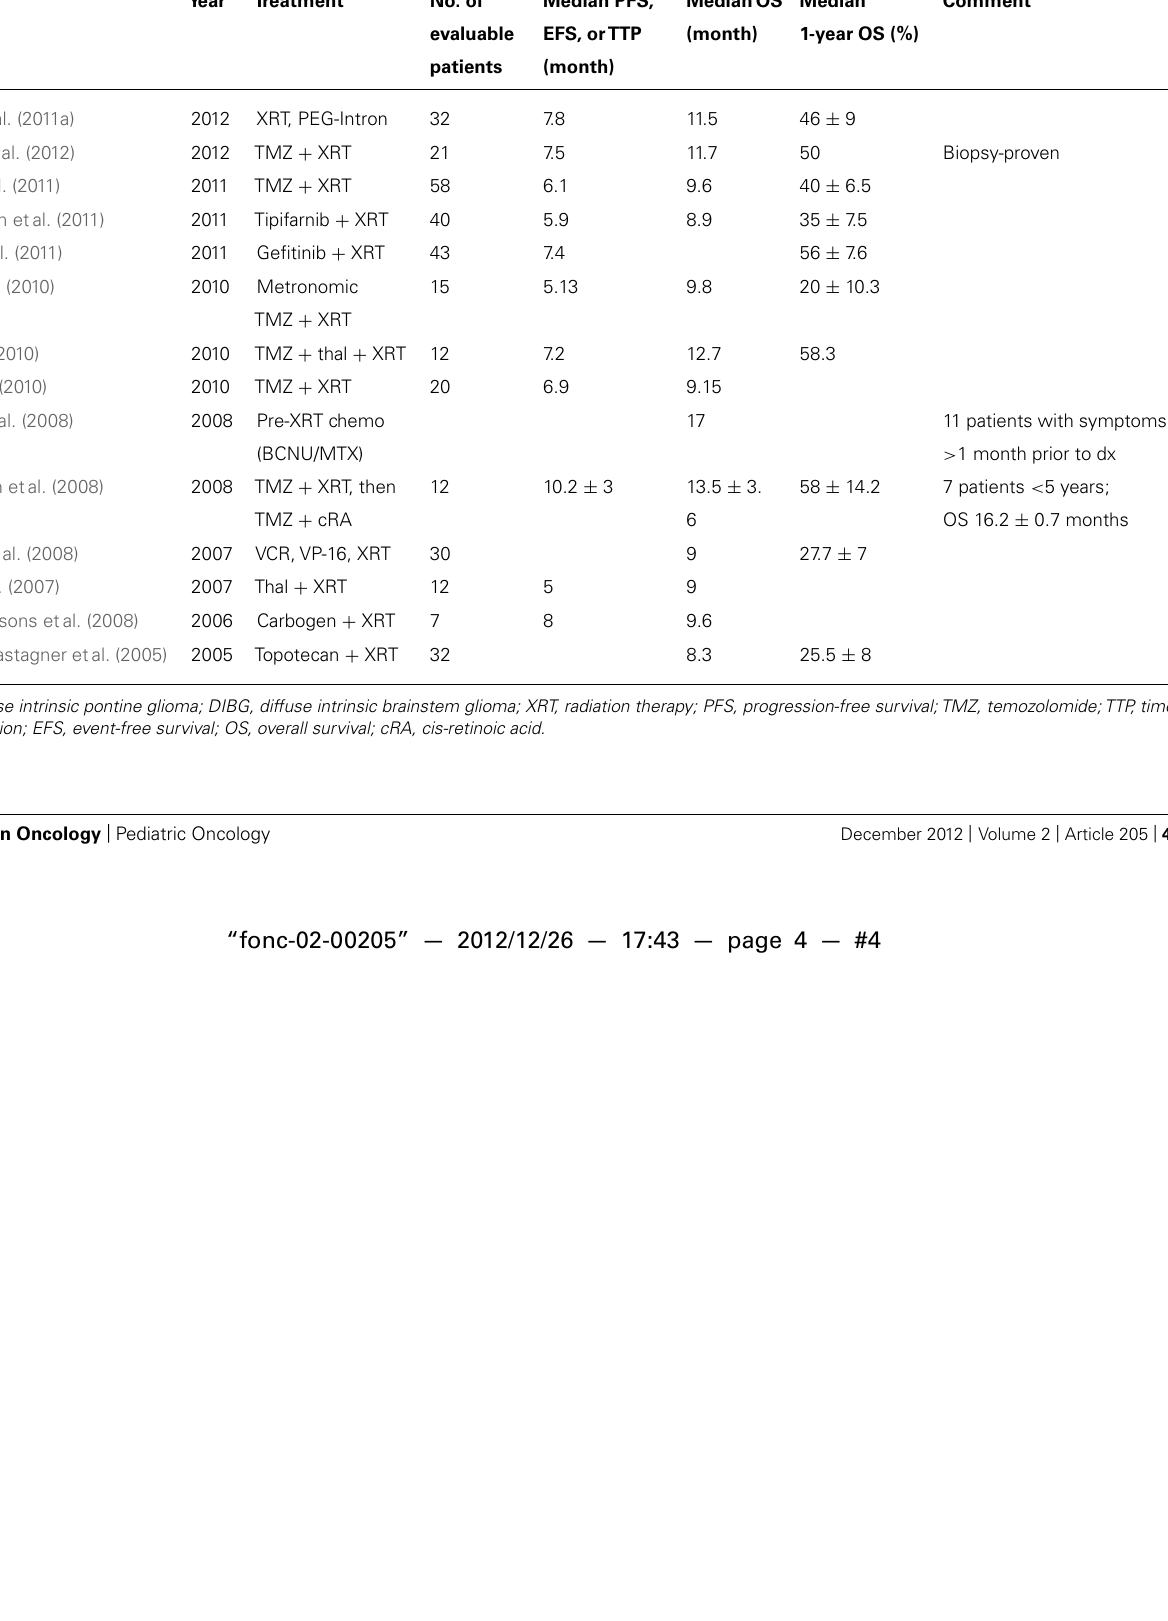
Median PFS, evaluable patients